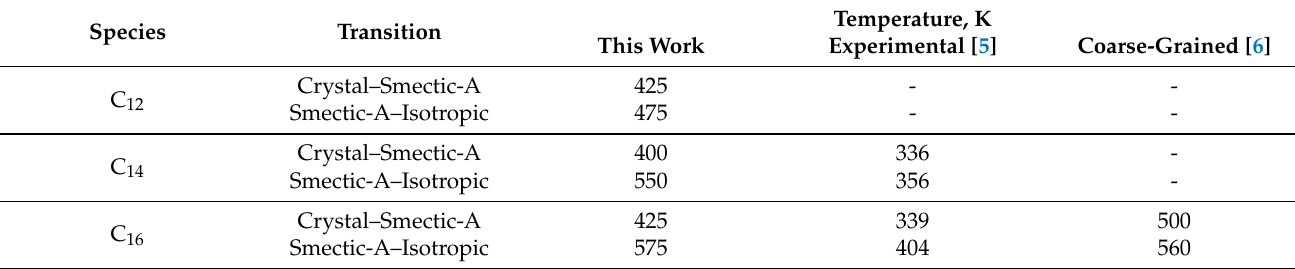
Table 1. Observed transition temperatures between the various phases for this series of ionic liquid crystals. Lee, et al. [5] did not observe any smectic phase for [C 12 MIm][NO 3 ], but observed the isotropic phase above 318K. As a function of alkyl tail length, the lower transition temperature exhibits a slight non-monotonicity for these species.